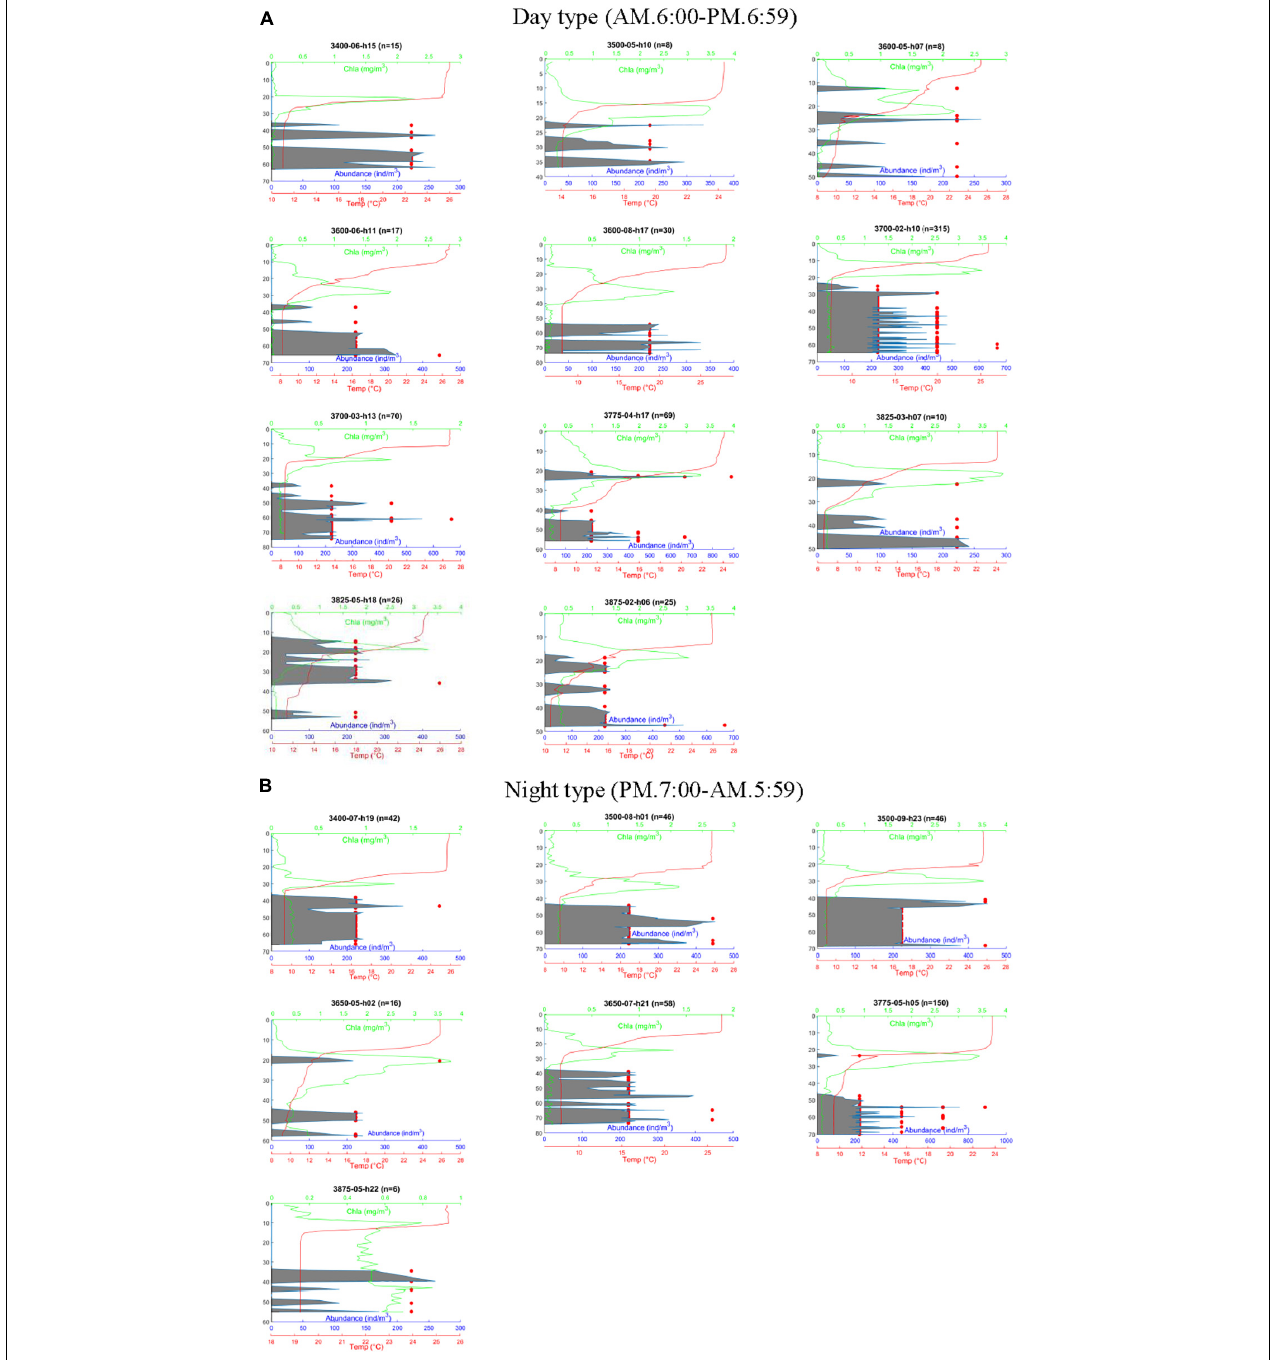
FIGURE 3 | Vertical profiles of Calanus sinicus abundance, chlorophyll a concentration, and temperature in the Yellow Sea. C. sinicus was captured using the VPR and numerated by morphometrics, while the other factors were surveyed using probes. Red dots represent the abundance of C. sinicus at a specific depth; gray areas represent the moving average of C. sinicus abundance based on the Savitzky-Golay method using MATLAB. (A) Day type. (B) Night type; n: total number of individuals captured by the VPR; h: survey time (24 h).